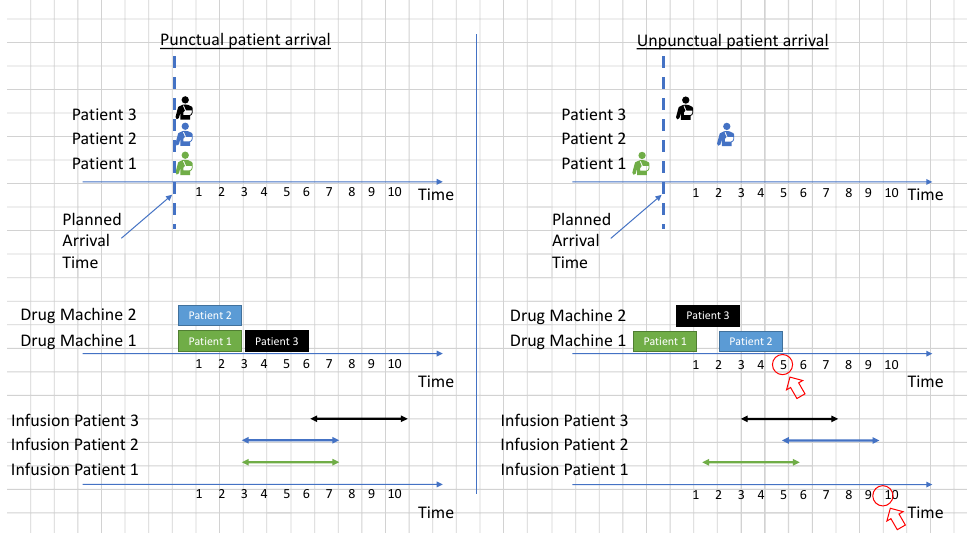
Figure 4. Example of a schedule of clustered appointments with punctual and unpunctual patient arrivals.